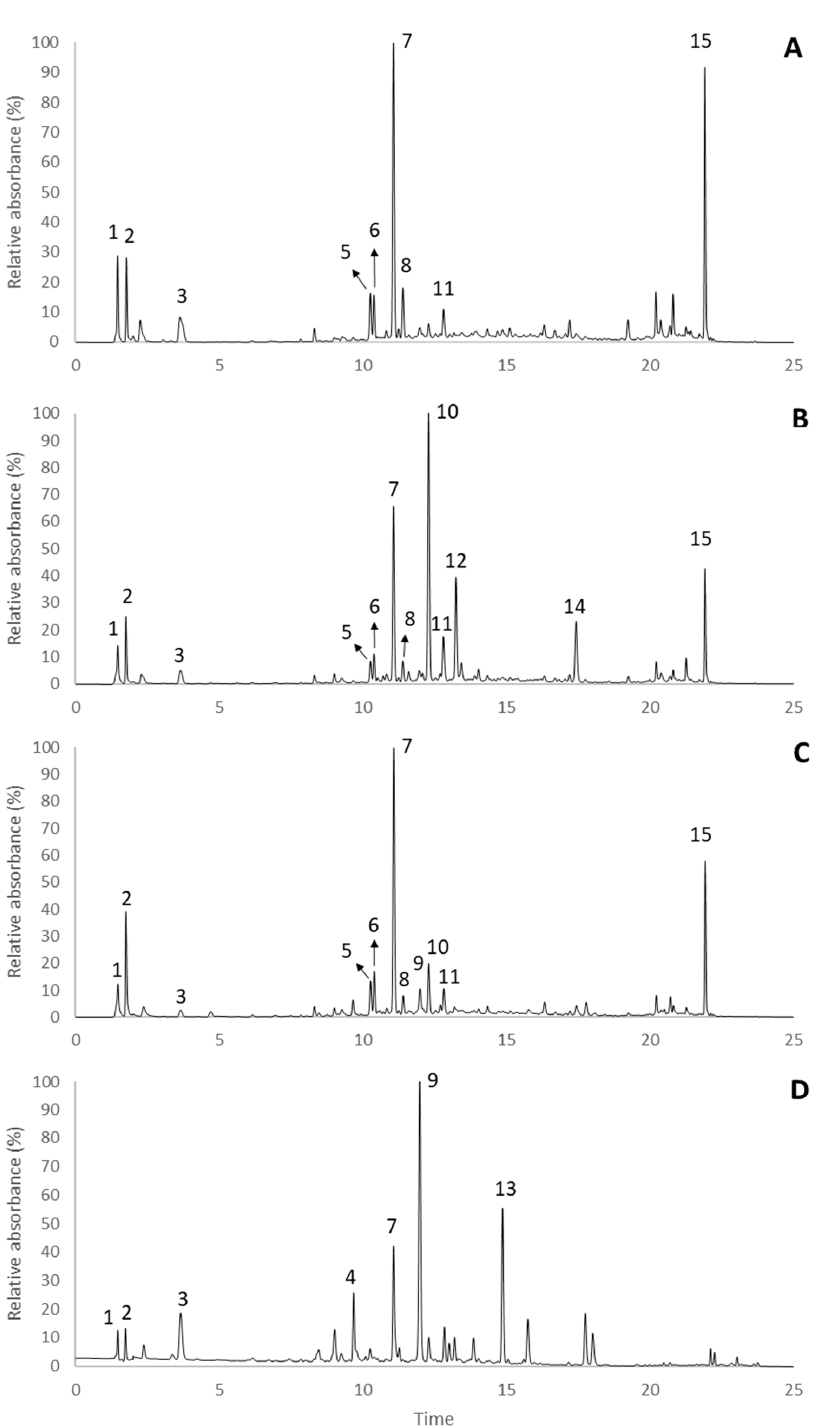
Figure 3. Chromatographic profiles of R. raetam (Forssk.) Webb hydromethanolic extracts from different seasons: ( A ) vegetative; ( B ) flowering; ( C ) fresh fruiting; and ( D ) mature fruiting stages recorded at 280 nm. Peak numbers correspond to those represented in Table 3.